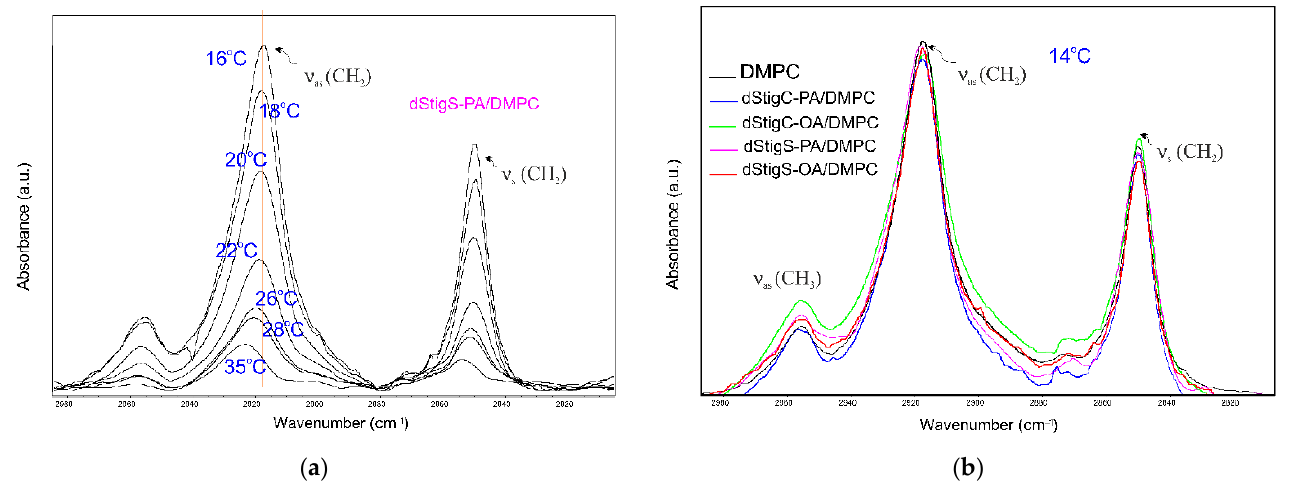
Figure 7. Infrared spectra of hydrated dStigS-PA/DMPC bilayer in the hydrocarbon chains region at different temperatures ( a ) and comparison of the spectra from the hydrophobic region of the bilayer of all tested compounds at the same temperature, in the gel phase ( b ); n dStigMAs /n DMPC = 0.20.